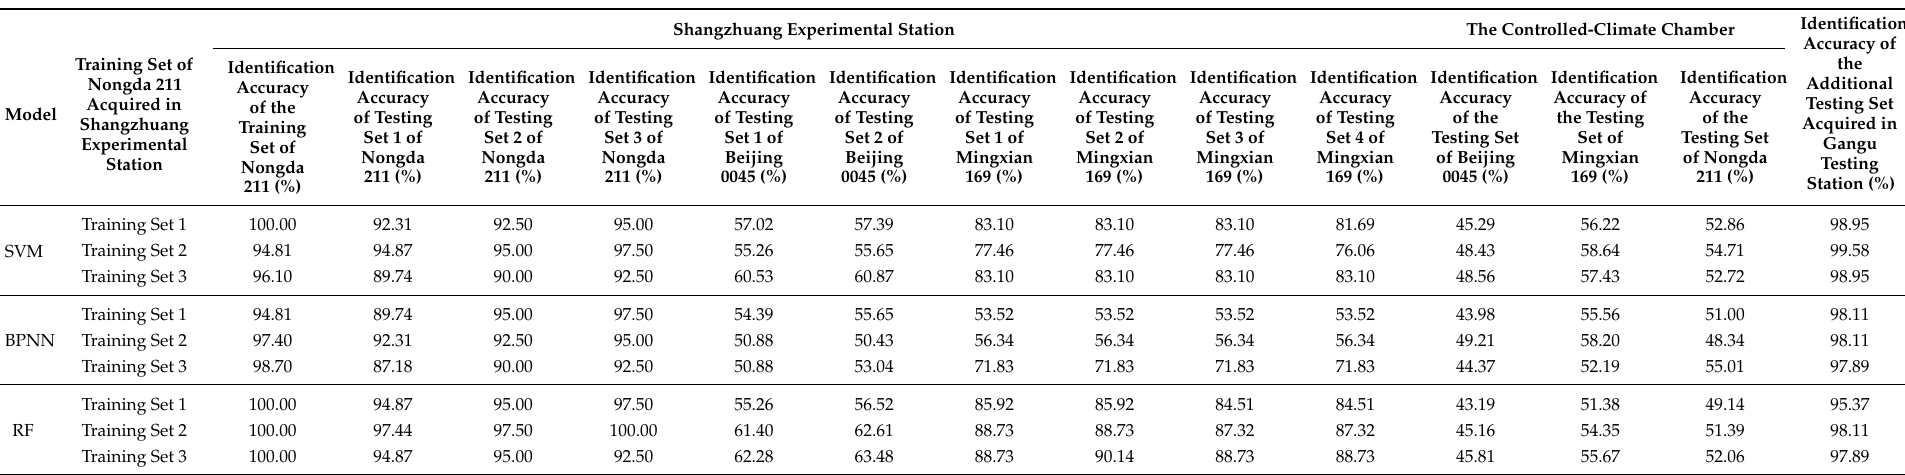
Table 13. Identification results for the individual-variety disease image testing sets acquired in the wheat field in Shangzhuang Experimental Station and under laboratory environmental conditions, and the additional testing set consisting of multi-variety disease images acquired in the wheat field in Gangu Testing Station using the SVM, BPNN, and RF models built based on the different training sets of the variety Nongda 211 consisting of disease images acquired in the wheat field in Shangzhuang Experimental